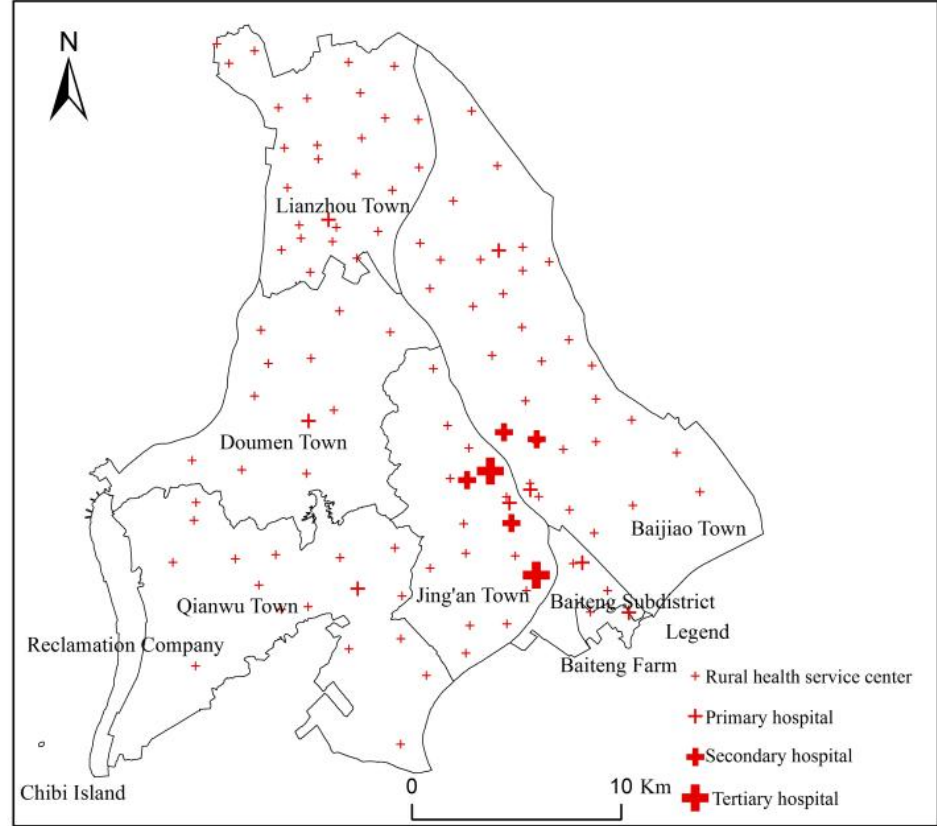
Figure 2. Spatial layout of multilevel medical facilities in Doumen District of Zhuhai (Guangdong Province). China, 2020. Table 1. Data sources and descriptions.